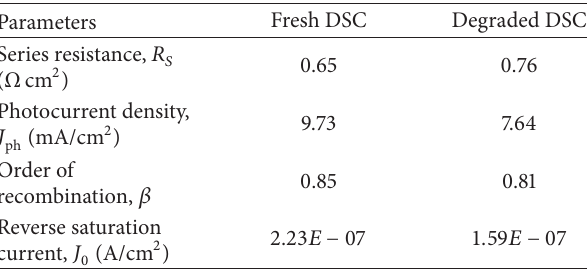
Table 1: Parameters used for simulating the experimental J-V curve for fresh and degraded